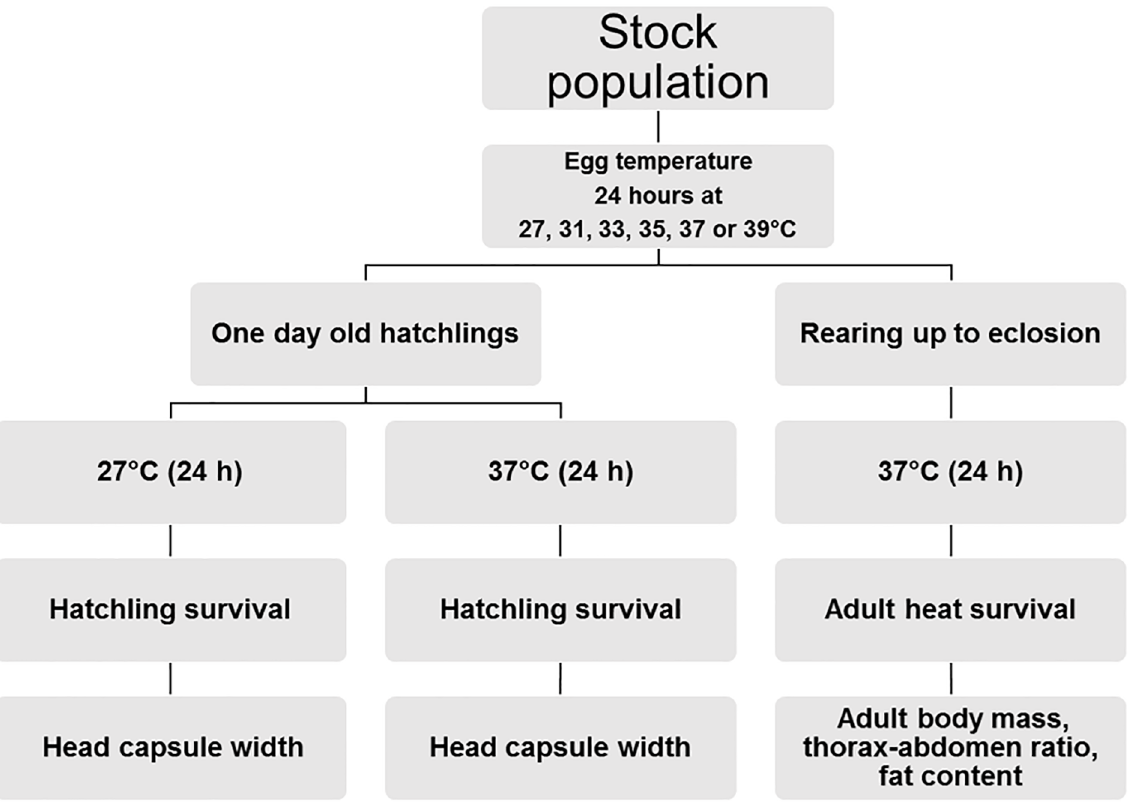
Fig 1. Schematic figure of the experimental design used. Eggs collectedfrom stock populationfemales were randomly divided and exposed to six temperatures for 24 hours each. Thereafter, one day-old hatchlings were exposedto either 27˚C or 37˚C, after which survival and headcapsule width were measured.Another cohort of resultinghatchlings was reared under control conditions until adult eclosionand then exposedfor 24 h to 37˚C, after which heat survival and other traits were scored.